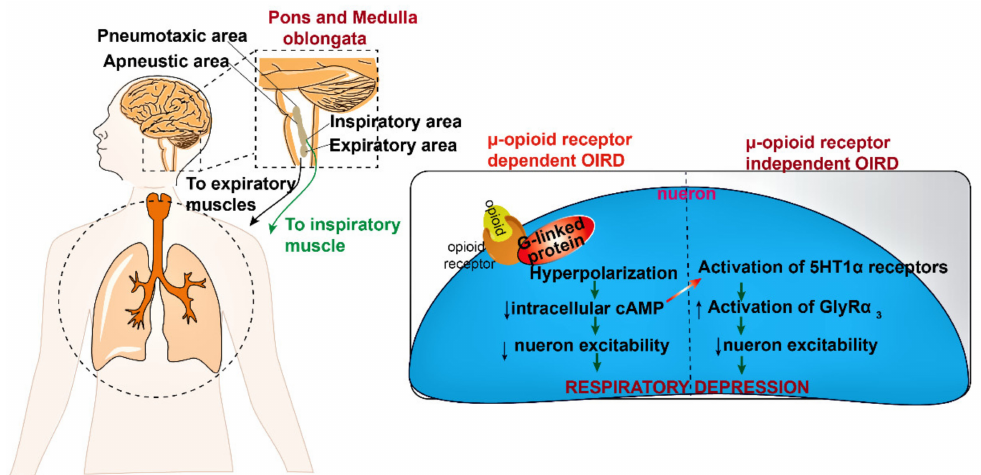
Figure 3. The pathophysiology and molecular mechanism of opioid-induced respiratory depression. Opioids activate the G-protein coupled µ -receptor and hyperpolarize the neurons through Na + /K + channels and decrease the intracellular cAMP level. This alteration in cAMP levels further activates the 5HT1 α and GlyR α 3 receptors which lead to a decrease in the neuron excitability and depress breathing by inhibiting the respiratory center (pons and medulla). (5-HT-serotonin; GlyR3-glycine receptor type-3, cAMP-cyclic adenosine monophosphate. Symbols: upward arrow-increased effect; downward arrow-decreased effect). (The image is illustrated with software chembio draw v.19 and Adobe Illustrator